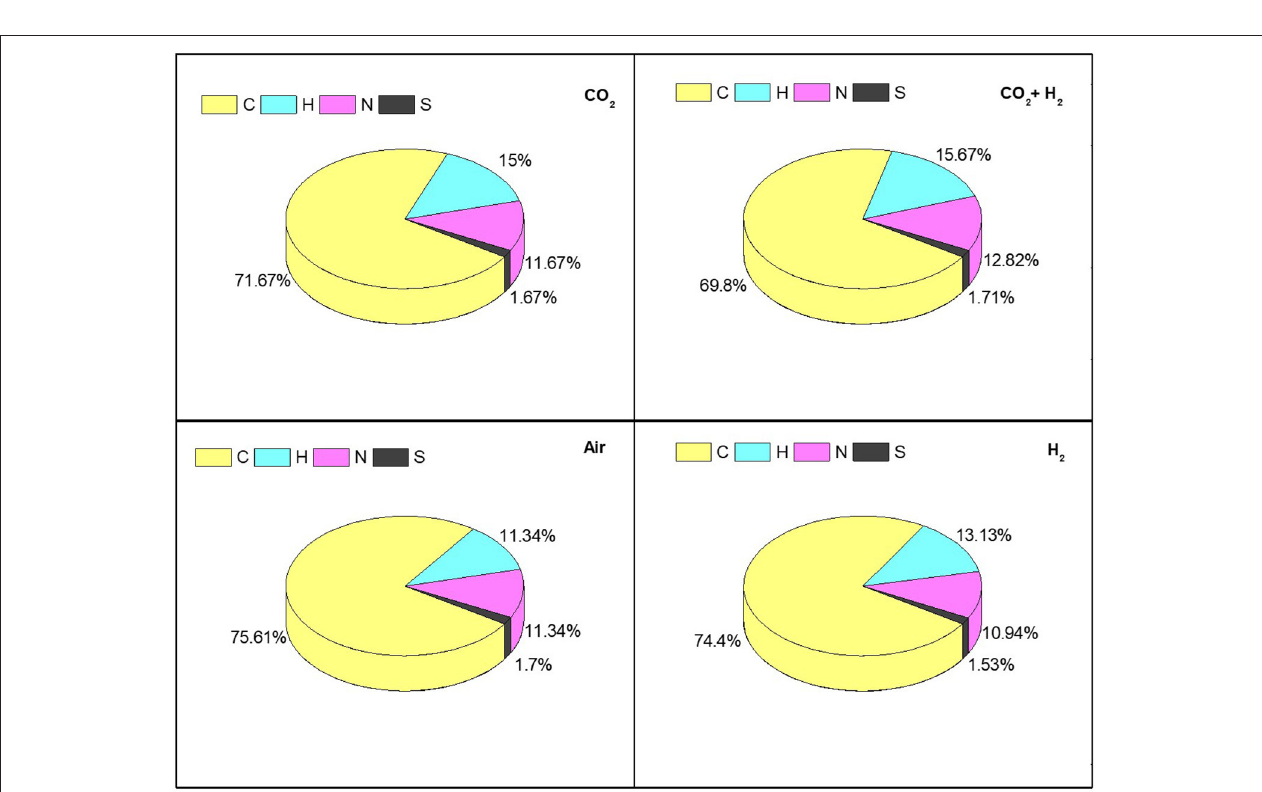
FIGURE 7 | Determining the relative abundance of CHNS influenced by photosynthetic activity and CO 2 sequestration trough elemental composition analysis for individual specific gas inlet